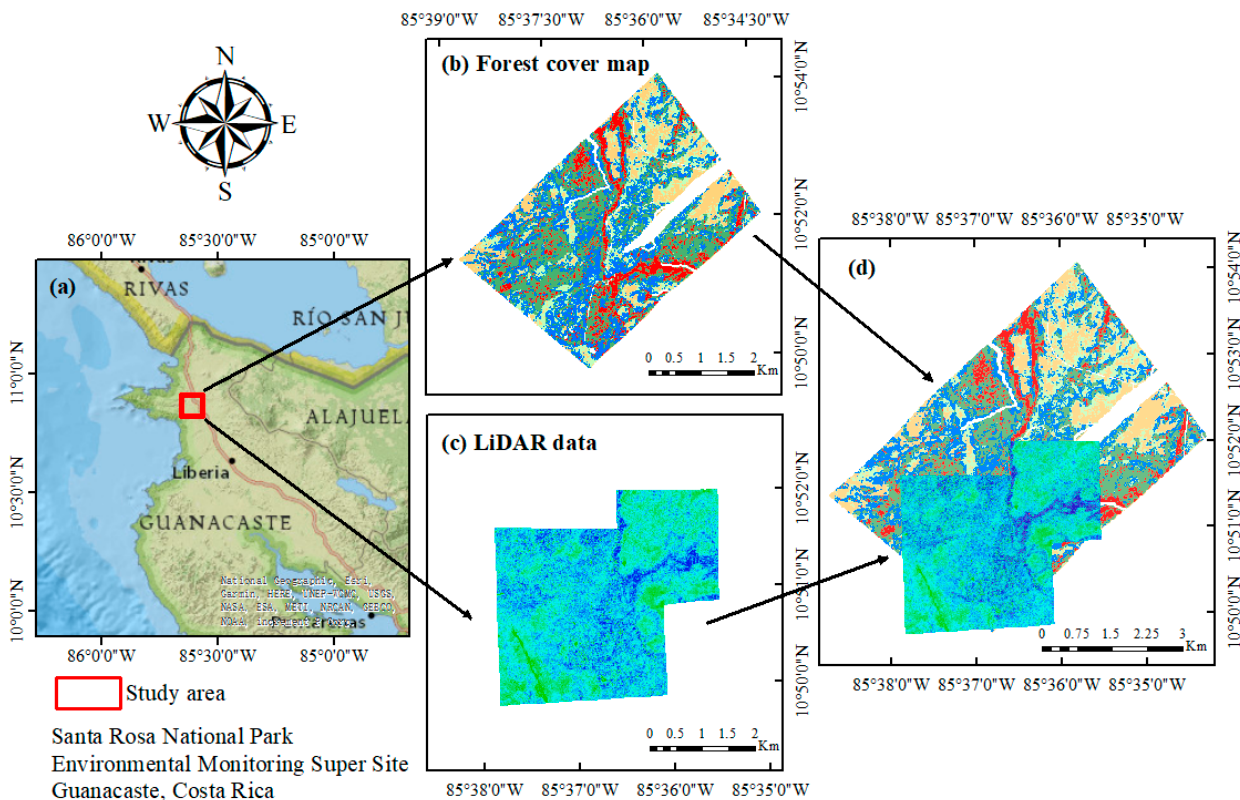
Figure 2. The study area at the Santa Rosa National Park Environmental Monitoring Super Site (SRNP-EMSS), Guanacaste, Costa Rica ( a ), the forest cover map from Zhao et al. (2021) [23] generated with LVIS and HyMap data in ( b ), Riegl Full-waveform Airborne LiDAR data 2021, acquired in SRNP-EMSS ( c ), the datasets from subfigures ( b , c ) overlay each other to define the study area.